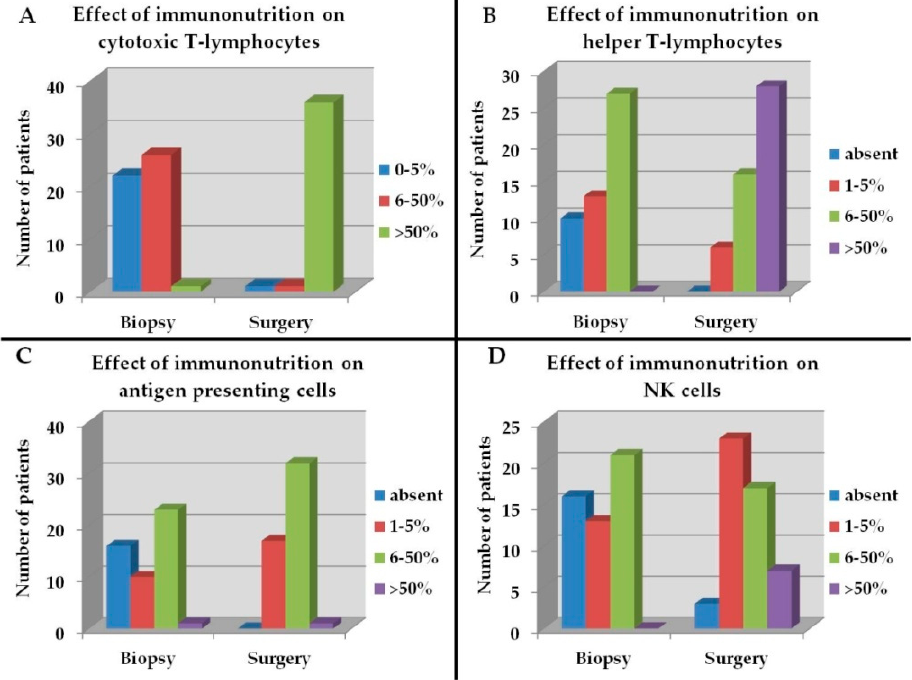
Figure 3. Modulation of lymphoid cells in the TME of patients receiving IN from biopsy to surgical specimen. ( A ), CTL; ( B ), TH; ( C ), APC; ( D ), NK.